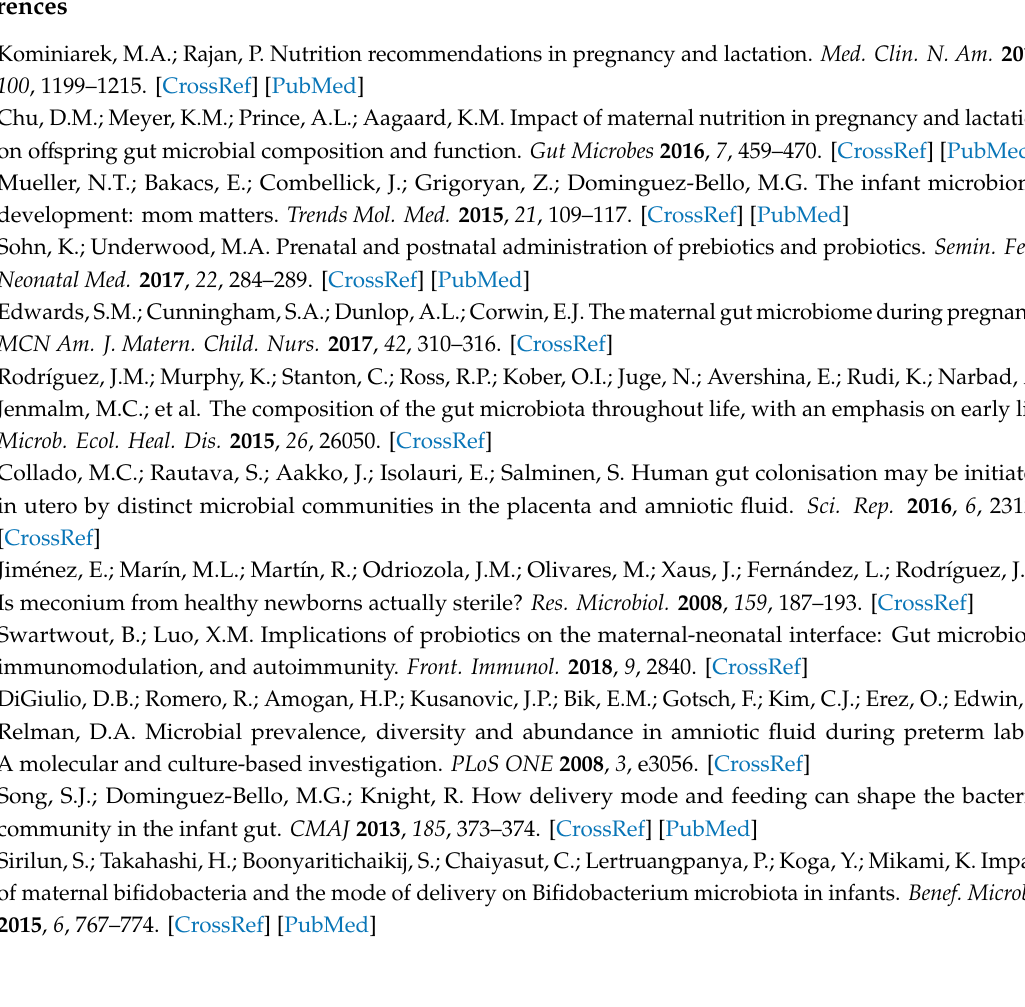
Table S1: Assessment of the matrix e ff ect on the quantification of immunoglobulins by